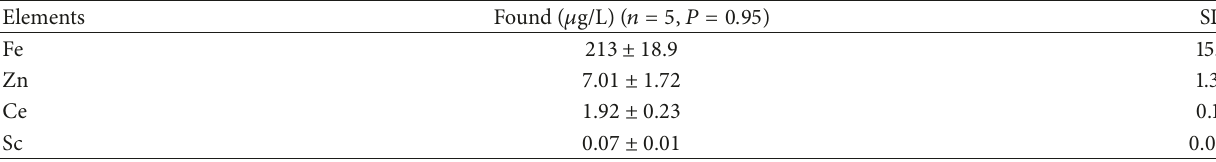
Table 4: Elements found in seawater by using the NAA method.